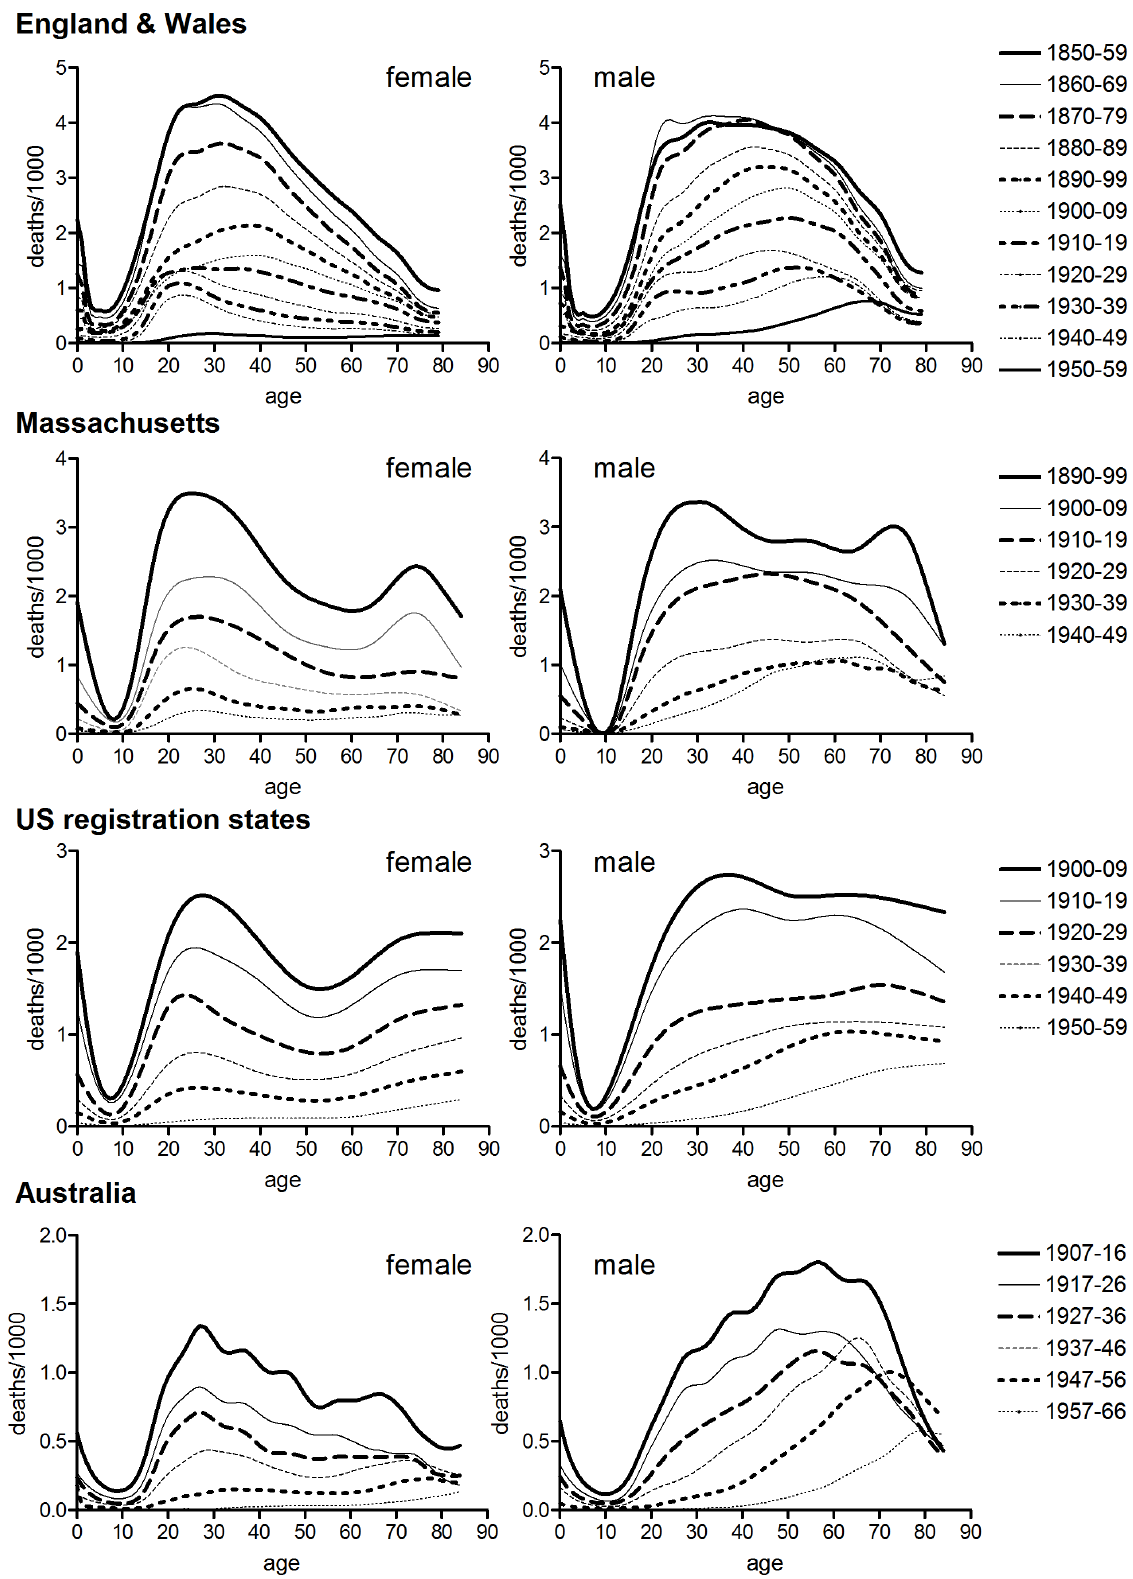
Figure 1. Age-specific tuberculosis mortality by period of death. Data refer to annual rates of respiratory tuberculosis (England & Wales, and Massachusetts), or all tuberculosis (US death registration states, Australia).